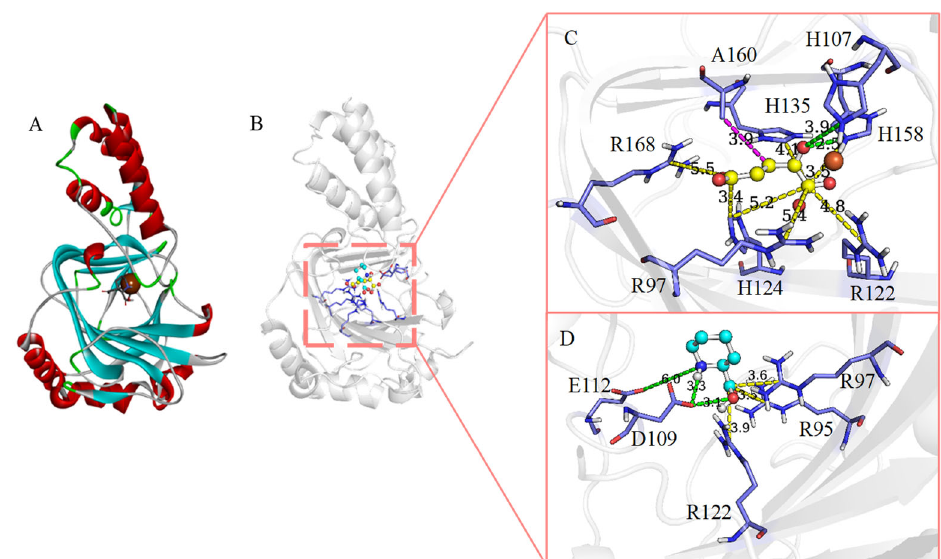
Figure 4. Structural analysis of substrate ‐ binding complex. ( A ) The overall structure of cis ‐ P3H (type I, AlphaFoldDB: P96010). The structure shows a double ‐ stranded β‐ helix core fold (cyan), which is sandwiched between the N ‐ terminal and C ‐ terminal α‐ helical domains (red). ( B ) The molecular docking result of cis ‐ P3H and L ‐ Pip. ( C ) Amino acid residues interacting with 2 ‐ OG (yellow); hy ‐ drophobic interaction (magenta dashed line), hydrogen bond (green dashed line), and salt bridge (yellow dashed line). ( D ) A “handlebar” mode for binding of substrate L ‐ Pip (cyan).